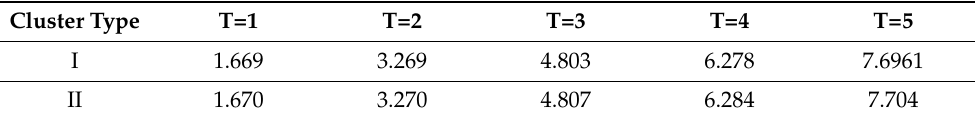
Table 27. The calculated result of the expected interest rate with time maturities 1, 2, 3, 4, and 5 years (in %).